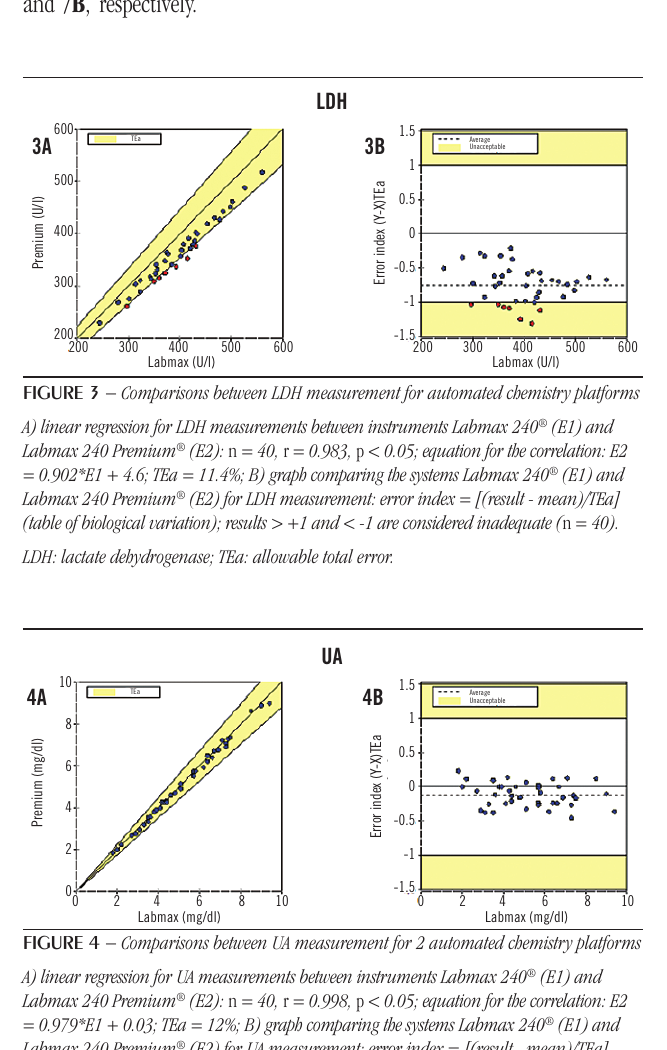
0.998 – Figure 5A ; GLU, r = 0.998 – Figure 6A ; TG, r = 0.997 – Figure 7A ). Dispersion graphs of data related to error variation for UA, TC, GLU, and TG can be visualized in Figures 4B , 5B , 6B , and 7B , respectively.